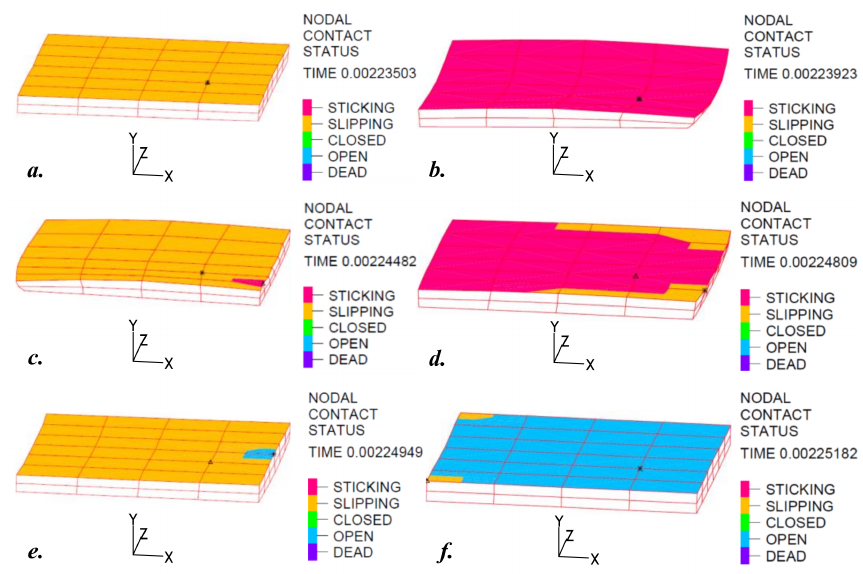
Figure 17. The contact state of the friction material in one driving cycle: ( a ) the slip state; ( b ) the stick state; ( c ) the slip state; ( d ) the stick state; ( e ) the slip state; ( f ) the friction material separates from the